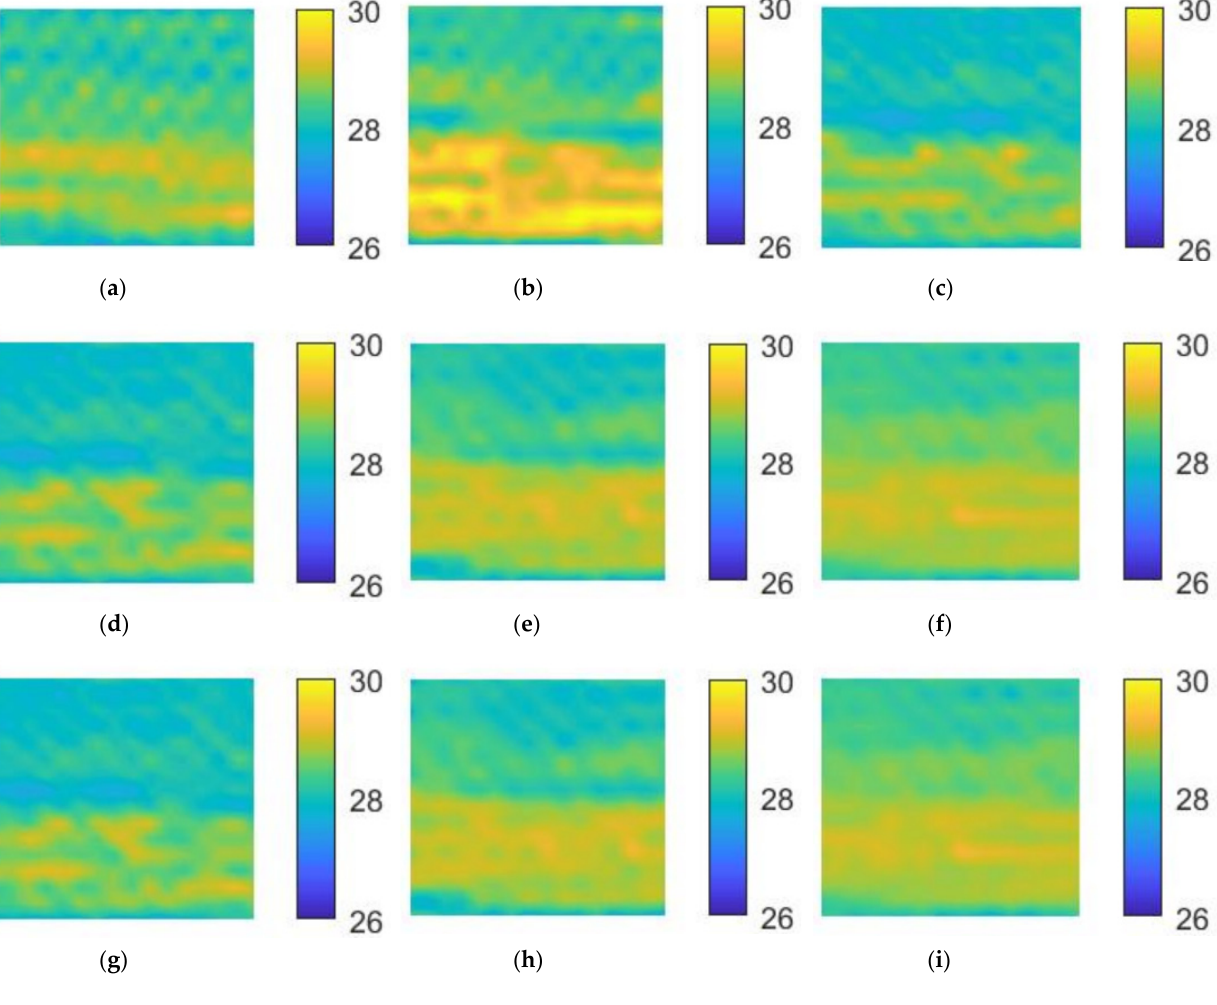
Figure 8. The experimental results of different methods for SST correction. ( a ) Truth; ( b ) forecast; ( c ) linear regression; ( d ) SVR; ( e ) LSTM; ( f ) CONVLSTM; ( g ) CONVLSTM-AT; ( h ) 3DCNN-CONVLSTM-AT; ( i ) 3DCNN-CBAM-CONVLSTM-AT.